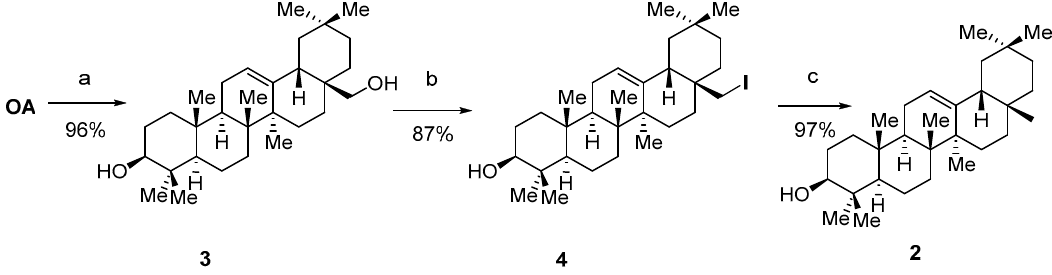
Figure 2. ( a ) LiAlH 4 , THF, reflux, 12 h; ( b ) I 2 , imidazole, PPh 3 , THF, reflux, 10 min; ( c ) Zn, AcOH, r.t. 4